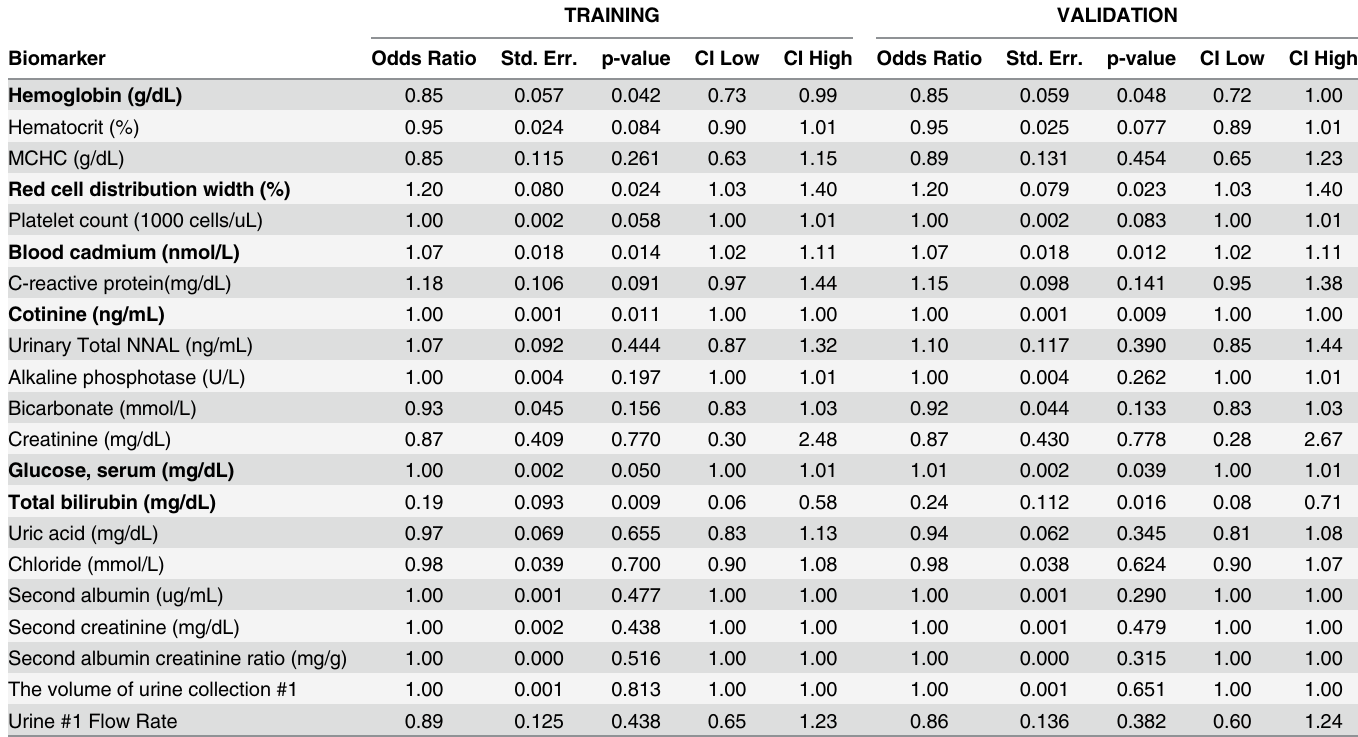
Table 3. Univariate Logistic Regression statistics.